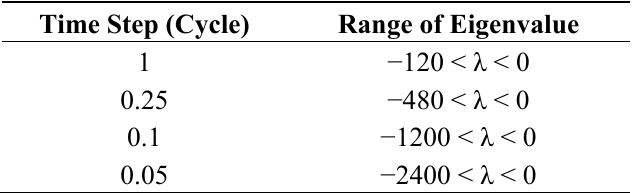
Table 1. Range of eigenvalues depending on the time step using the RK2 method.